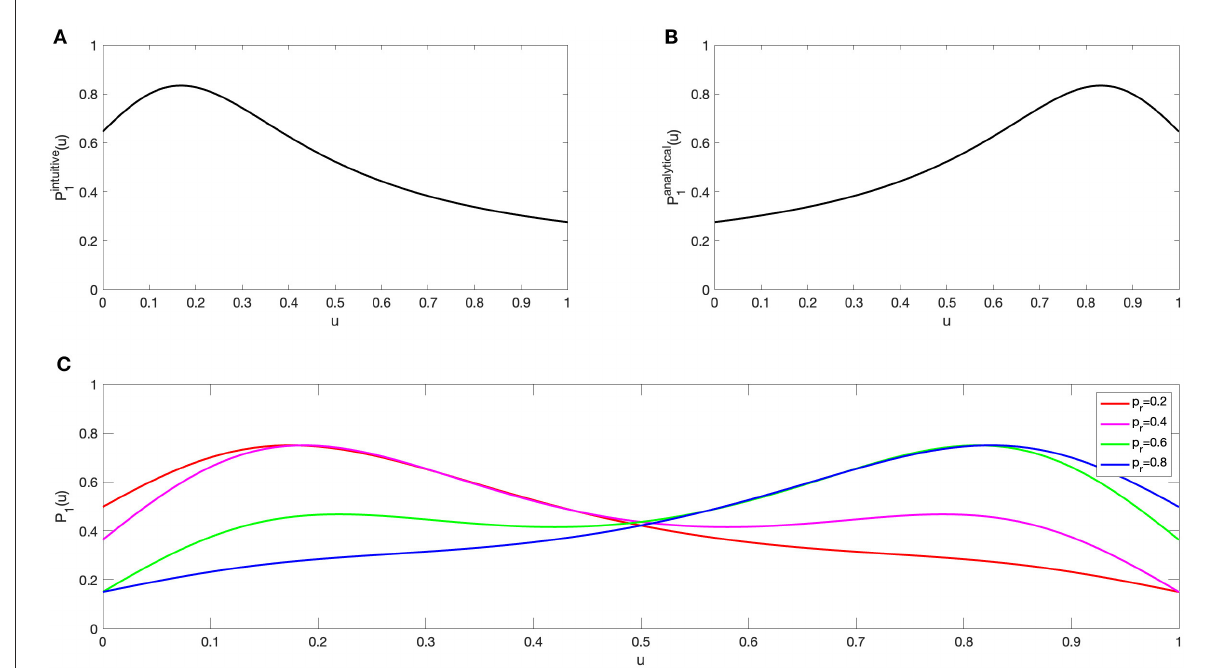
FIGURE3 Forward transition probability. (A, B) indicate the forward transition probabilities of an intuitive and analytical individual, respectively. These two functions are linearly combined using the specific individual’s reasoning propensity p r . Some examples of forward transition probability functions for different p r are shown in (C)